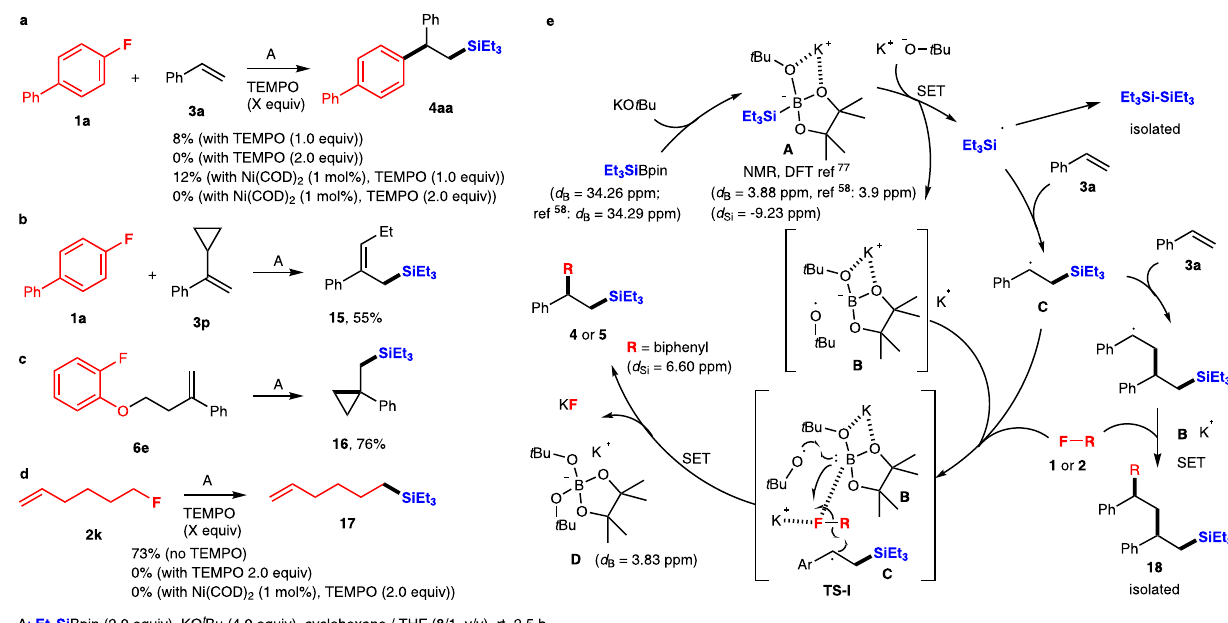
Fig. 5 Mechanistic study. a Effect of TEMPO for carbosilylation of 1a , 3a , and Et 3 SiBPin. b , c Radical clock experiments. d Effect of TEMPO for the reaction of alkyl fl uoride 2k and Et 3 SiBPin. e Proposed reaction